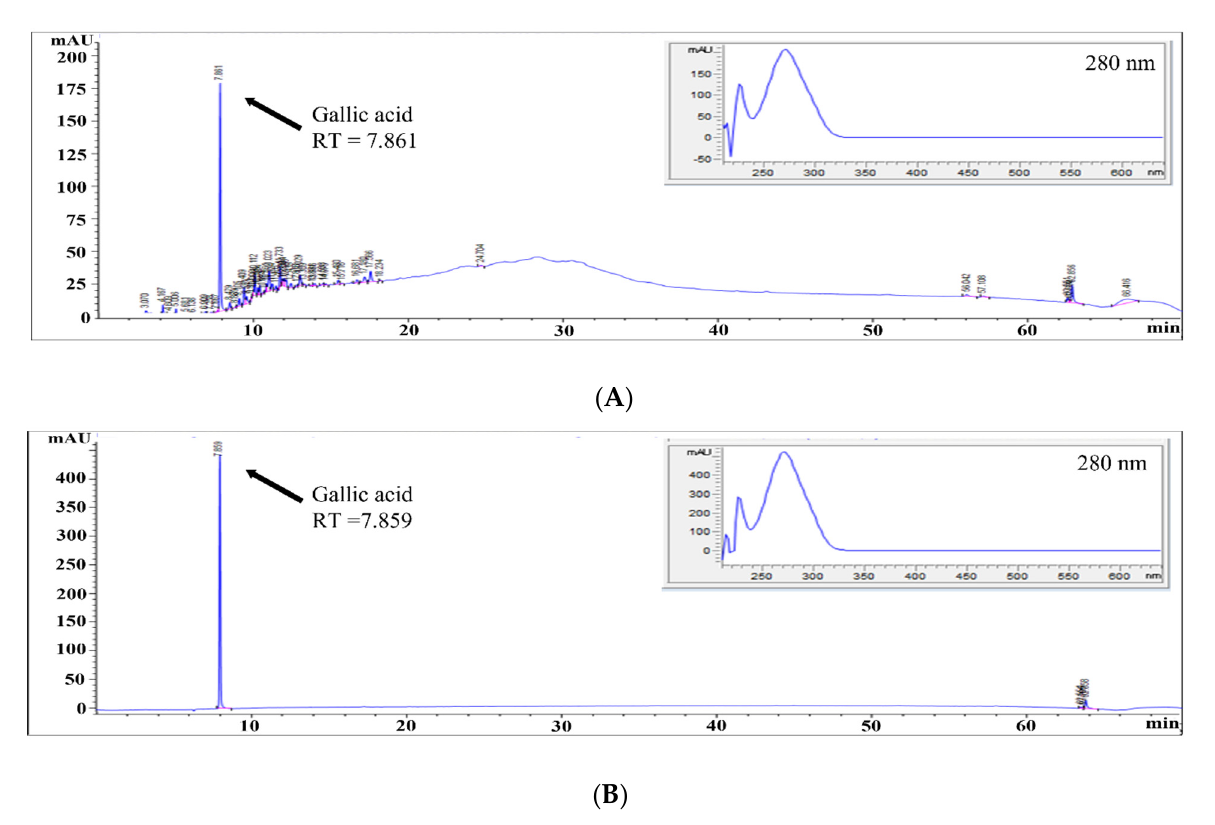
Figure 4. HPLC chromatograms for quantitative and qualitative analysis for the determination of gallic acid concentration in ASE at 280 nm. ( A ) Chromatogram and DAD spectrum (190–640 nm) of gallic acid from ASE. ( B ) Chromatogram and DAD spectrum (190–640 nm) of gallic acid standard (0.1 mg/mL).